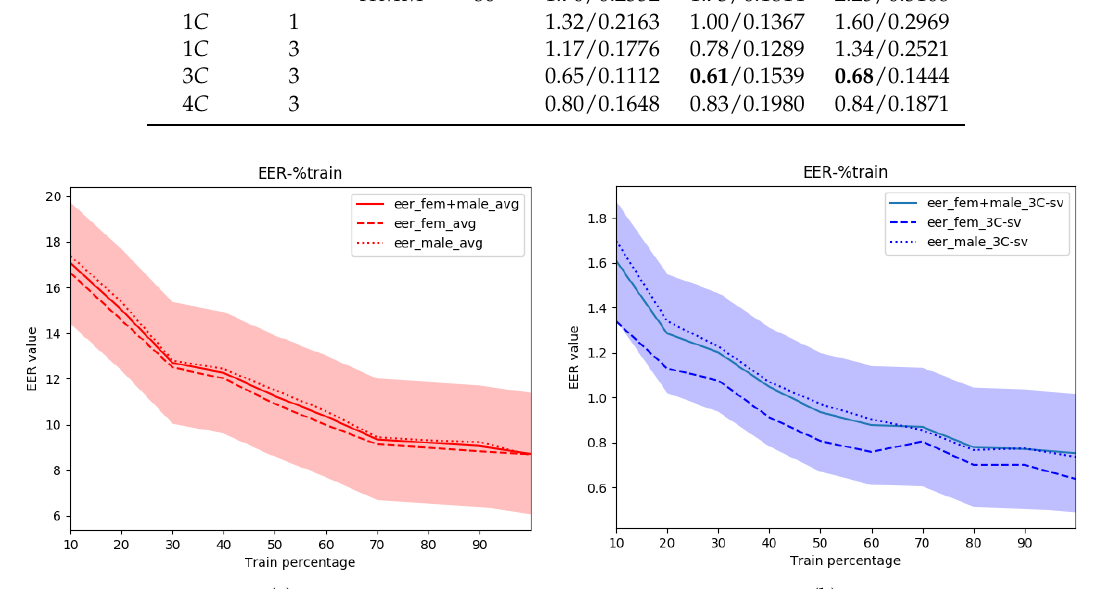
Figure 4. Results of EER% varying train percentage where standard deviation is shown only for both gender independent results. ( a )average embeddings; ( b